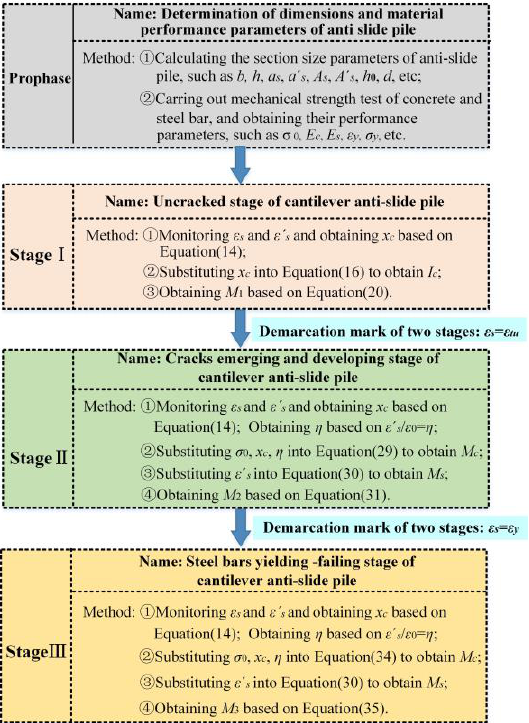
Figure 19. Calculation flow chart of bending moment of anti-slide pile at each stage.